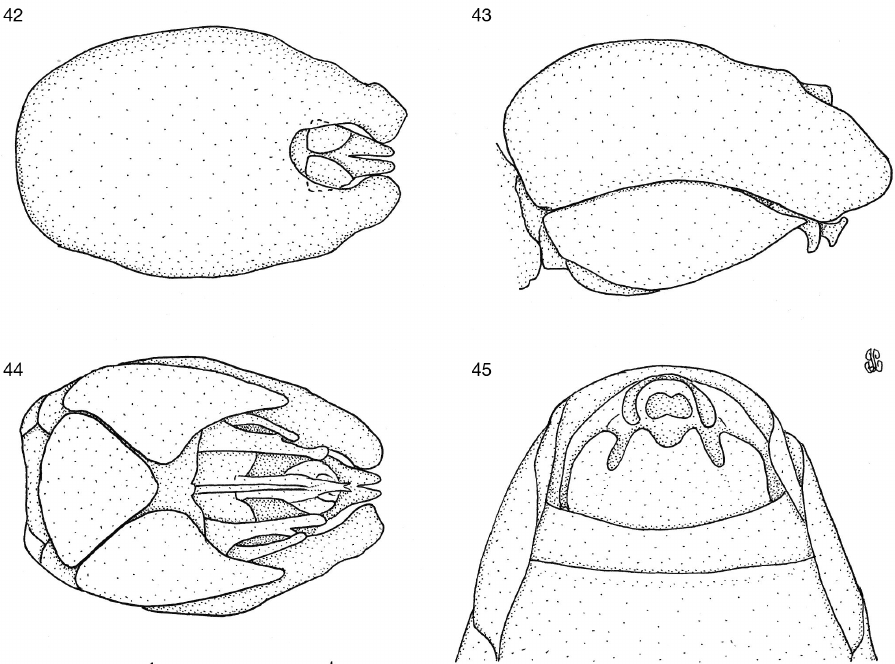
Figures 42–45. Laphyctis gigantella terminalia: 42 male (Sawmills) dorsal 43 same, lateral 44 same ventral 45 female (Buyamuryama Boma) ventral. Scale = 1 mm, setation